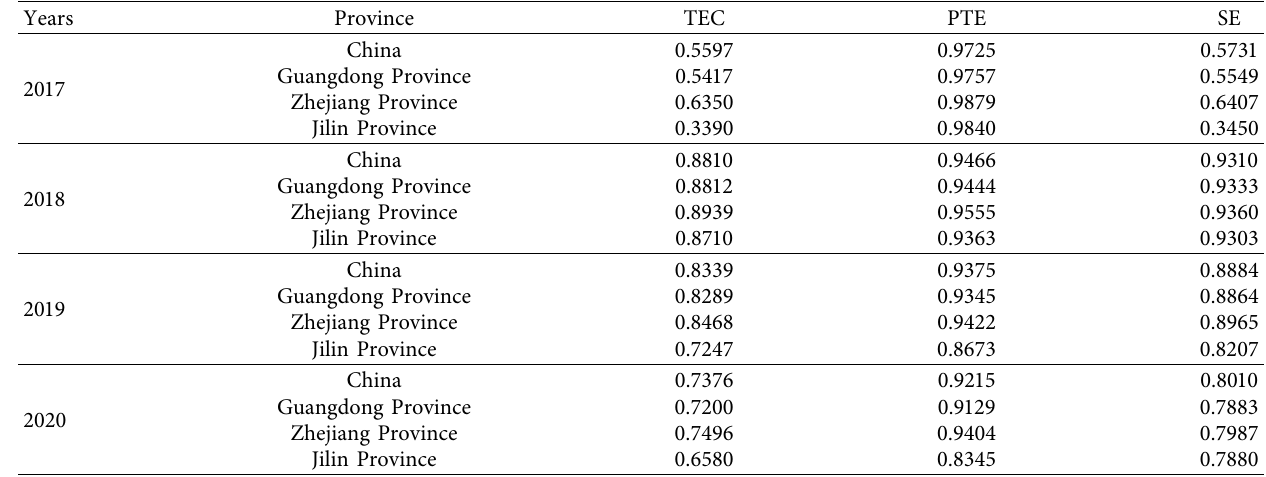
Table 2: National SME financing efficiency results between 2017 and